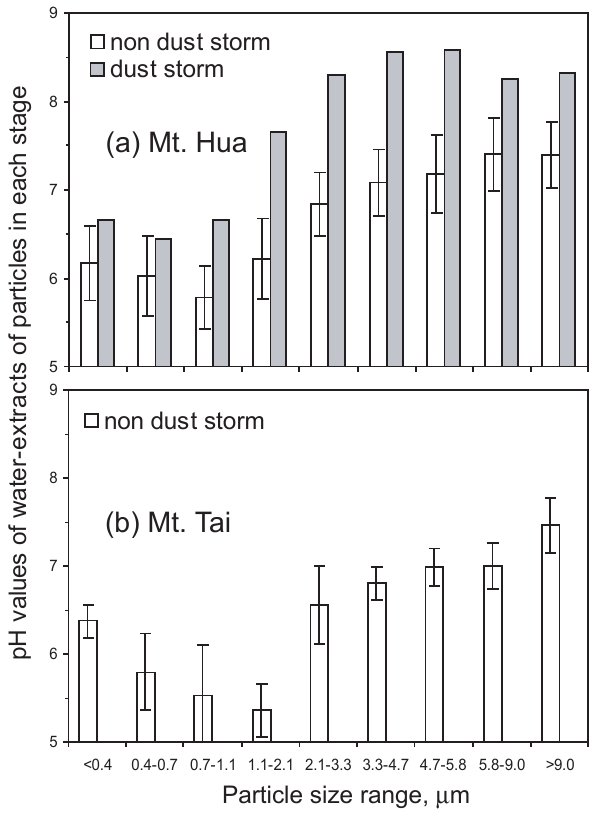
Fig. 13. Acidity of water-extracts of particles in each stage at (a) Mt. Hua and (b) Mt. Tai during the non-dust storm and dust storm periods.